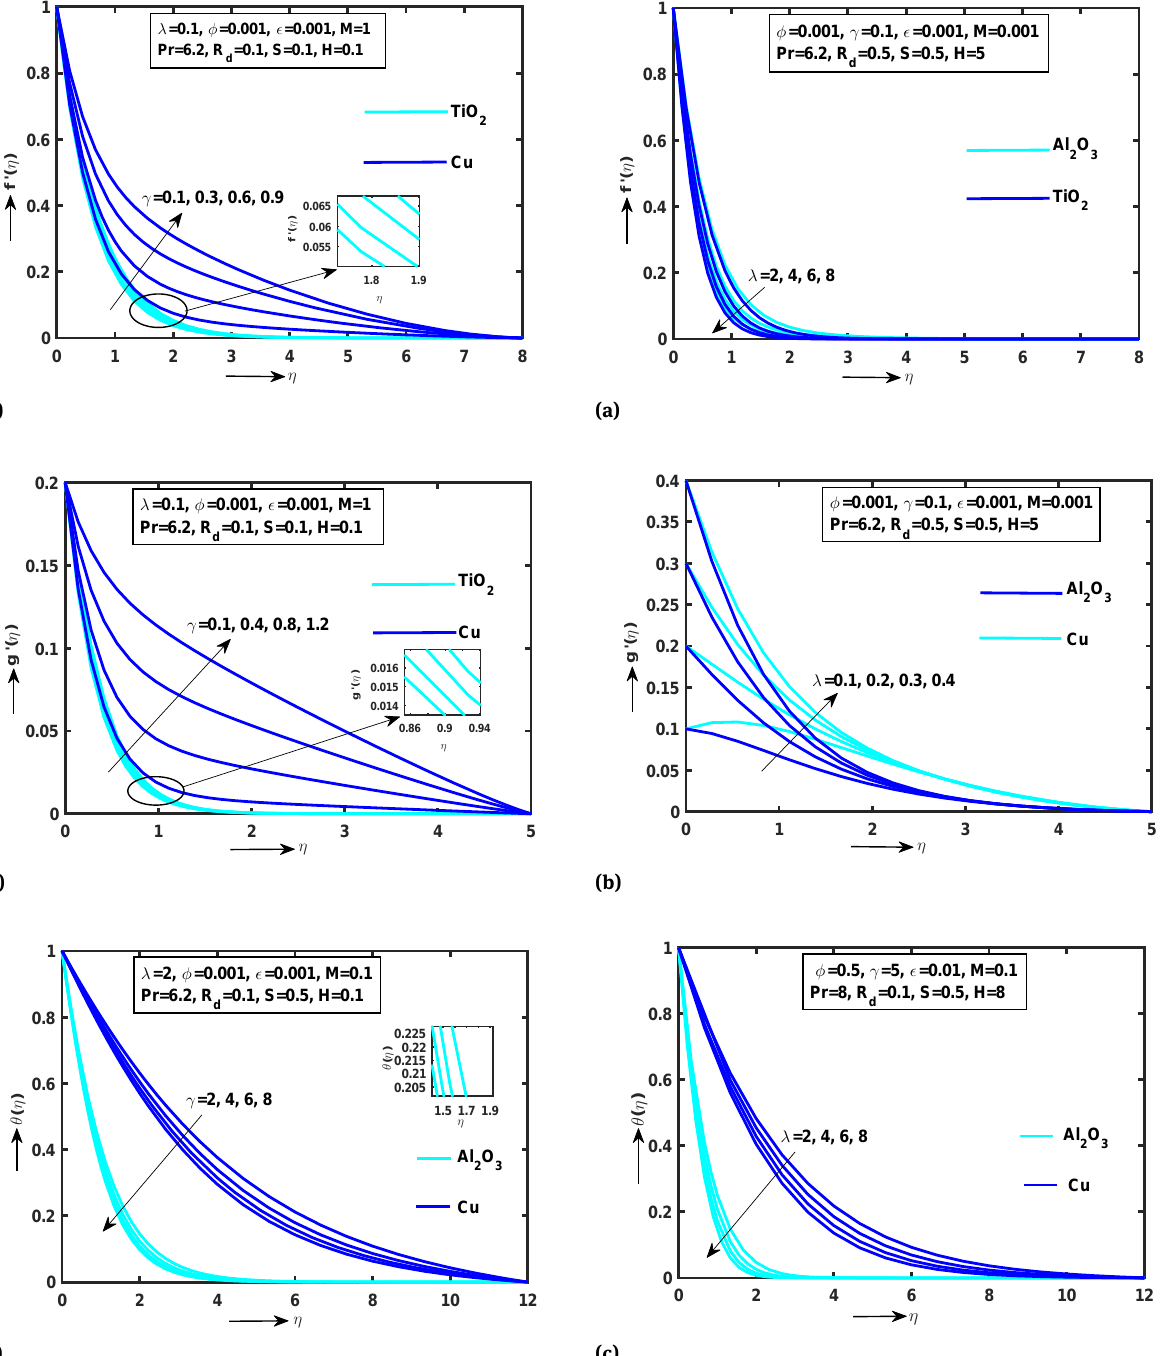
Figure 3: (a) Significance of γ on f (cid:48) ( η ) (b) Significance of γ on g (cid:48) ( η ) (c) Significance of γ on θ ( η )